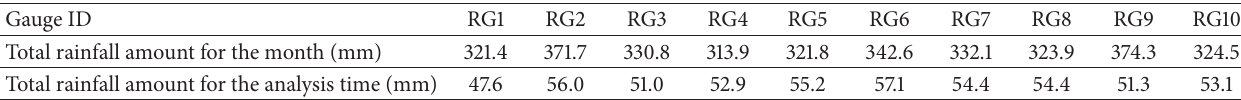
Table 2: Total rainfall amount for the month and per analysis